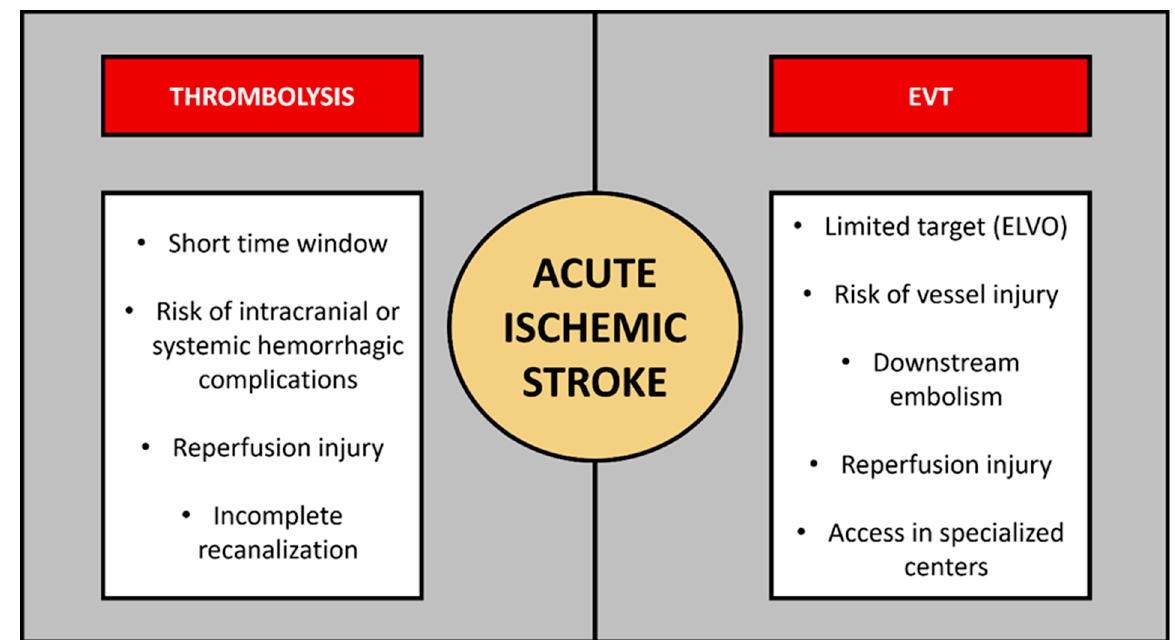
Figure 1. Current acute ischemic stroke specific therapies and challenges associated with each modality. In addition to limited eligibility for acute ischemic stroke treatments, specific challenges exist in case of thrombolysis or thrombectomy, respectively. ELVO—emergent large vessel occlusion; EVT—endovascular thrombectomy.